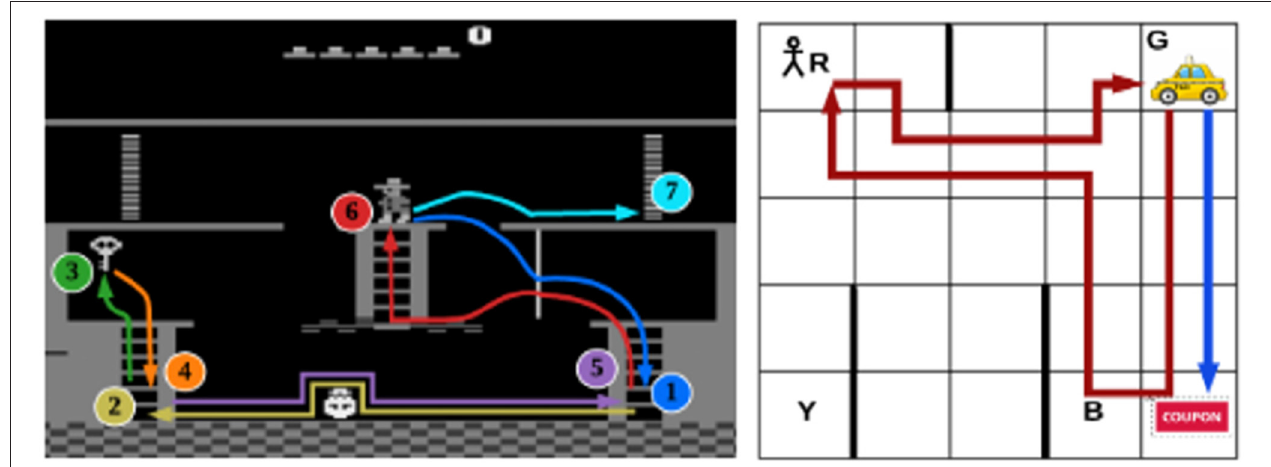
FIGURE 8 | Summarized policies for Montezuma’s Revenge (left), and the “taxi” problem (right), (from Lyu et al. (2019), p. 2975, reproduced with permission).